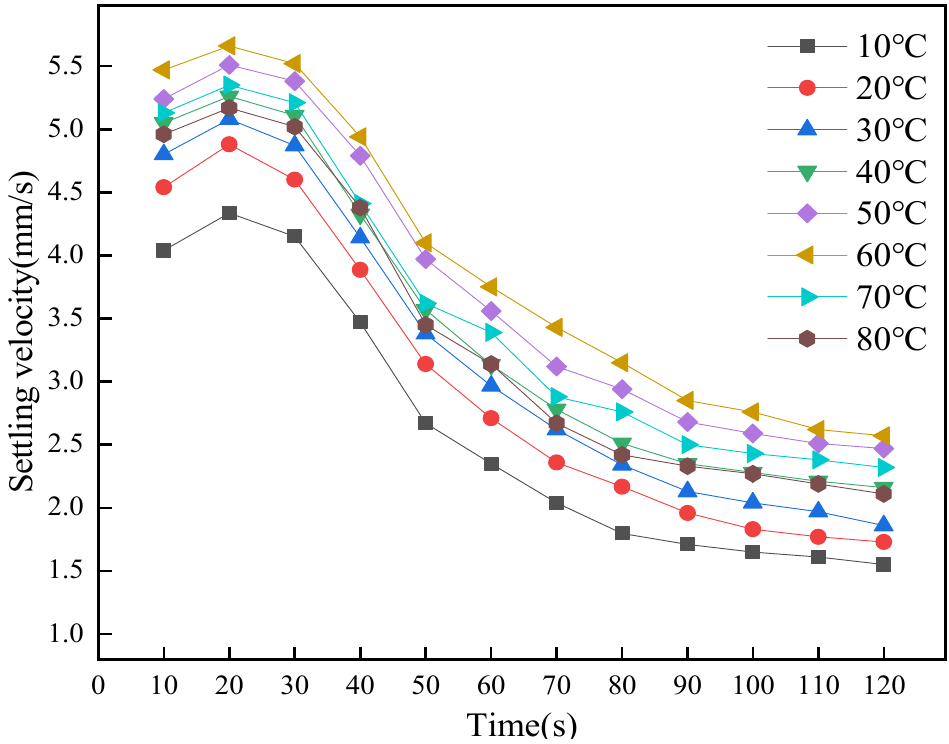
Figure 5. Relationship between tailings settling velocity and time at different temperatures.